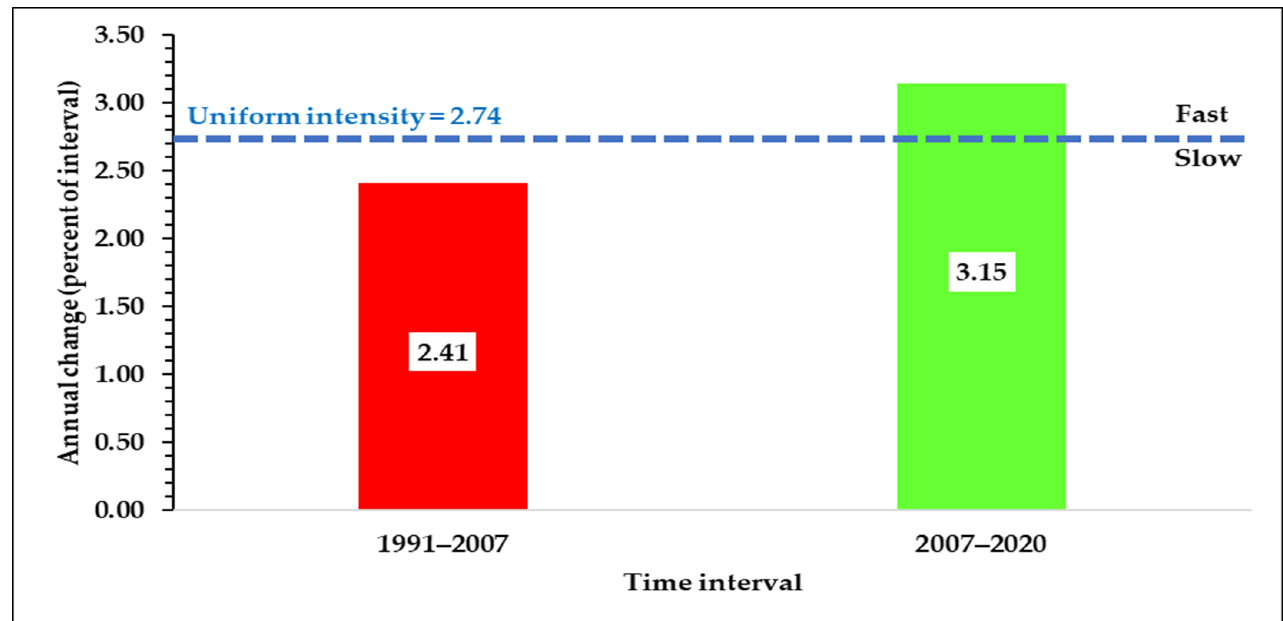
Figure 3. Interval level intensity during 1991 ‒ 2007 and 2007 ‒ 2020 for the KLCRS.